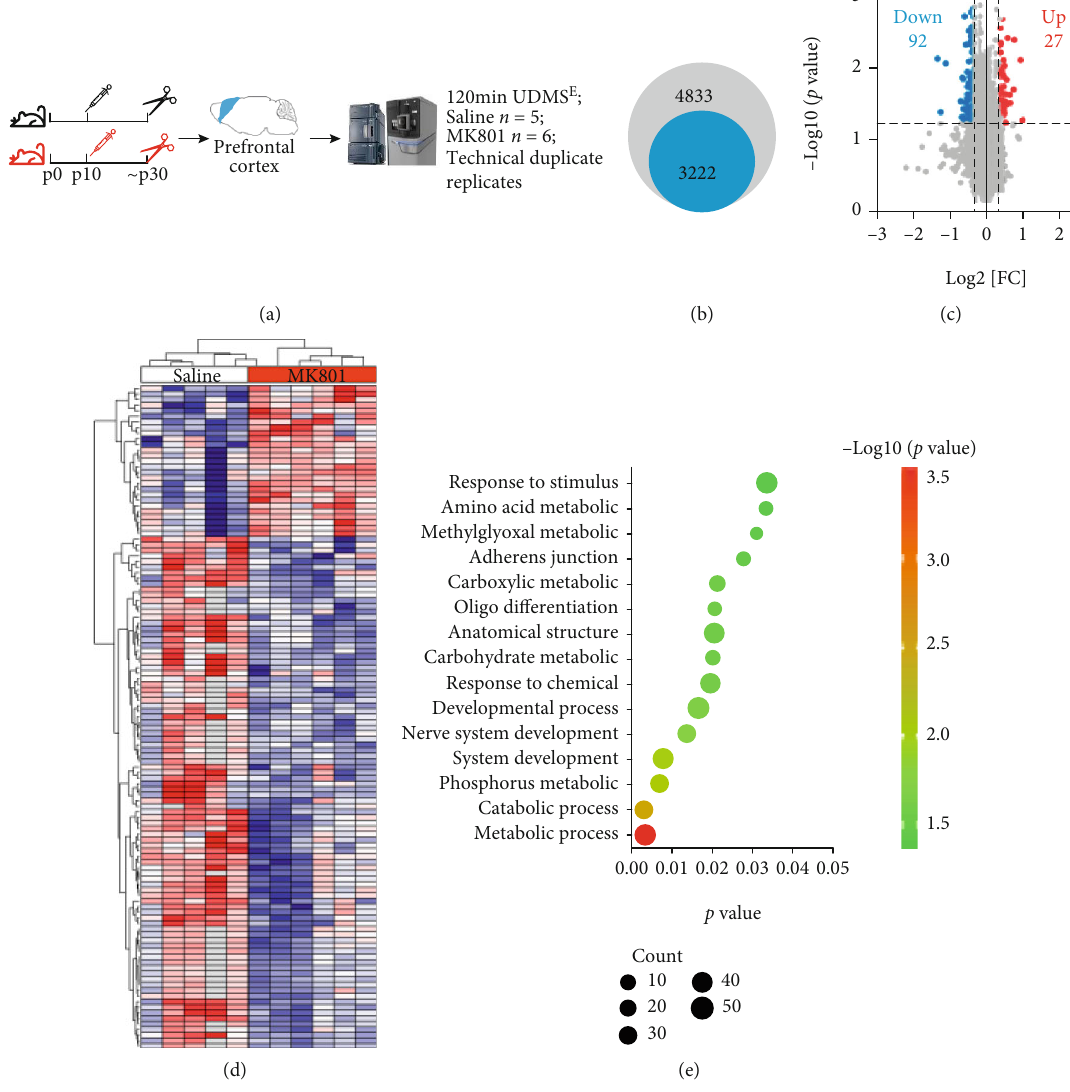
Figure 3: Overview of the altered proteome of PFC in adolescent mice by data-independent UDMS E approach. (a) Schematic diagram of data-independent proteomic acquisition. Saline or MK-801-treated mice were sacri fi ced on ~ PND 30. The PFC was dissected for trypsin digestion and a 120min gradient LC-MS acquisition. Duplicate technical replicates were performed for each sample. n = 5 of the saline group and n = 6 of the MK801 group. (b) 4833 proteins were identi fi ed, and only 3222 of them that the CV value of technicalreplicates ≤ 20 % across all samples were used for subsequent analysis. (c) Volcano plot of signi fi cantly expressed proteins, Fold change ≥ ∣ 1 : 3 ∣ , adjusted p < 0 : 05 . (d) Hierarchical clustering of signi fi cant proteins. Each square represents one sample. Red: upregulated. Blue: downregulated. Protein ’ s intensity was scaled across all samples and displayed as Z score. (e) The top GO enrichment of biological function of all signi fi cant proteins. Circle size represents the protein numbers in each item. p value was adjusted by FDR